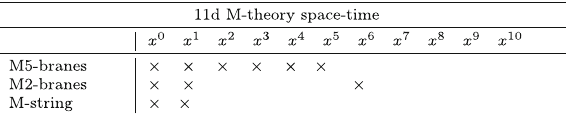
topological vertex formalism [34]. The partition function Z N , M takes the form of an infinite series expansion. The expansion parameters depend on the choice of a preferred direction common to all vertices of the toric web diagram.